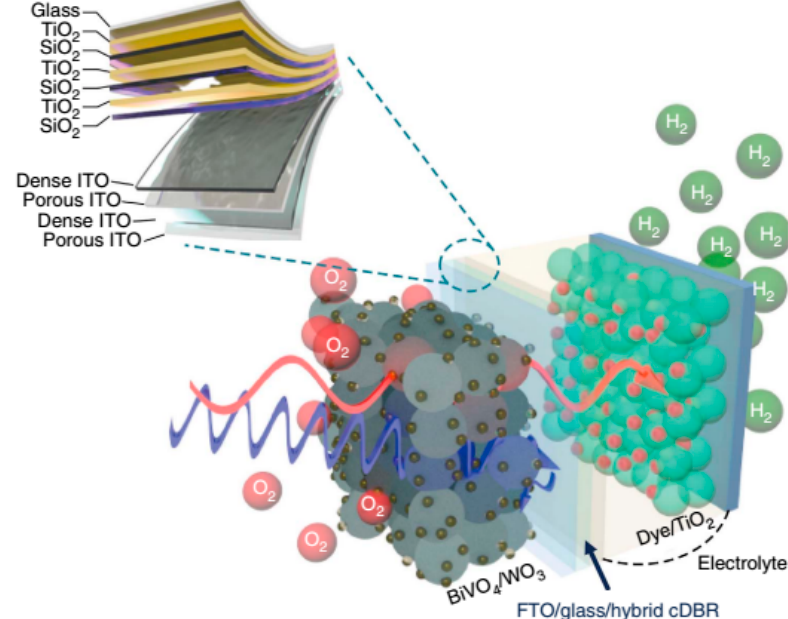
Figure 15. Schematic illustration of a PEC tandem system based on BiVO 4 / WO 3 and DSSC. Reproduced from [191], with permission from Springer Nature, 2016.